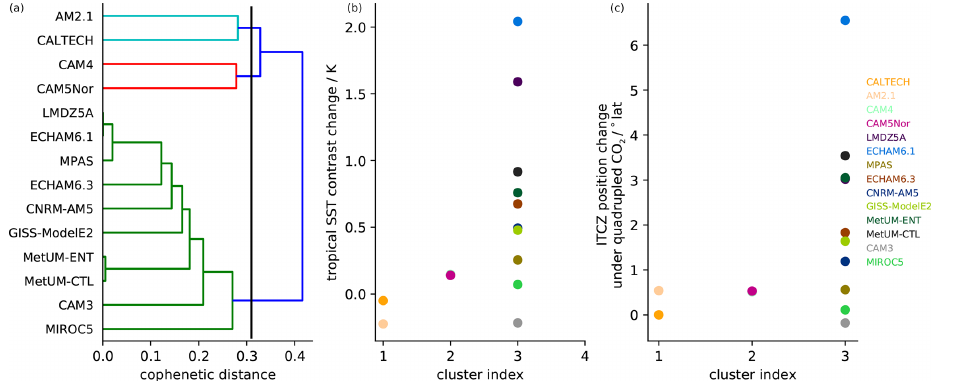
Figure 8. Model clustering based on the difference between the Aqua4xCO2 and AquaControl global networks (a) along with the warming- induced changes in the tropical SST contrast (b) and ITCZ position (c) for the three identified clusters. (a) The dendrogram obtained from the clustering of the difference in the zonal-mean network characteristics. The vertical line indicates the level of cophenetic distance at which we split the models into the three clusters.